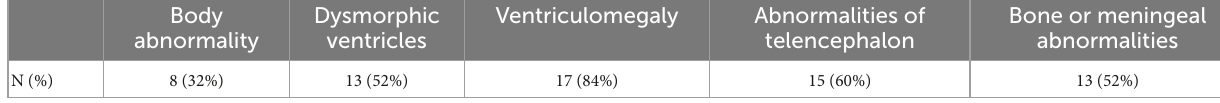
TABLE 1 Additional abnormalities (aside from posterior fossa findings) were found on fetal MRI in Chiari II